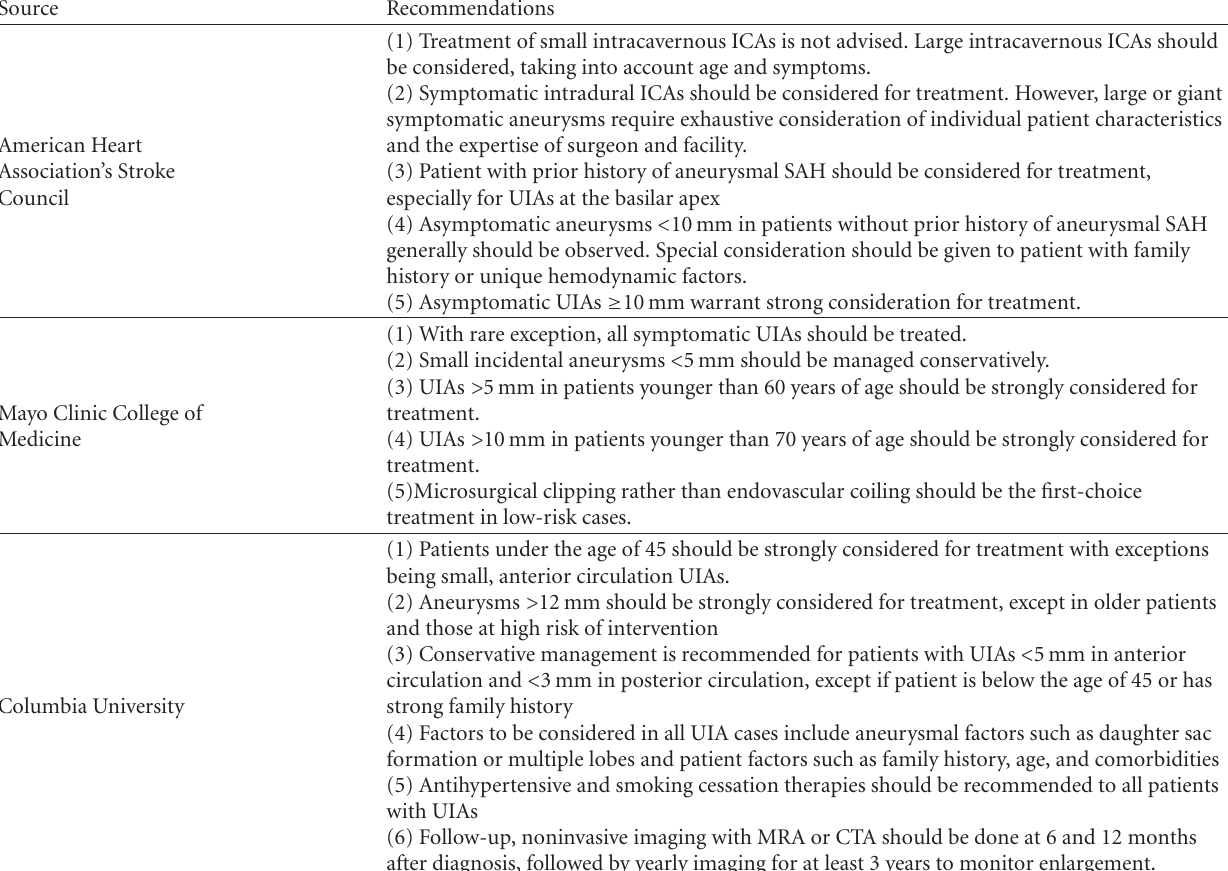
Table 2: Treatment